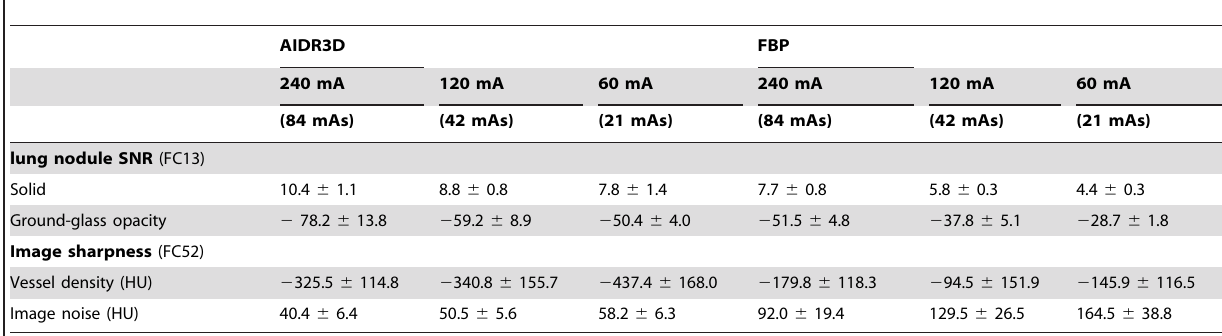
Table 5. Results of phantom study at different tube currents with AIDR3D and FBP (without AIDR3D).